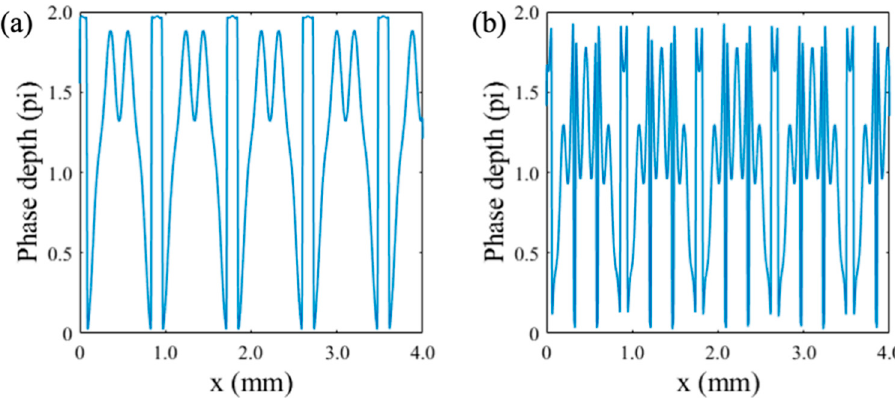
Figure 6. Optimized holograms for ( a ) 1 × 9 and ( b ) 1 × 15 spot array generation.